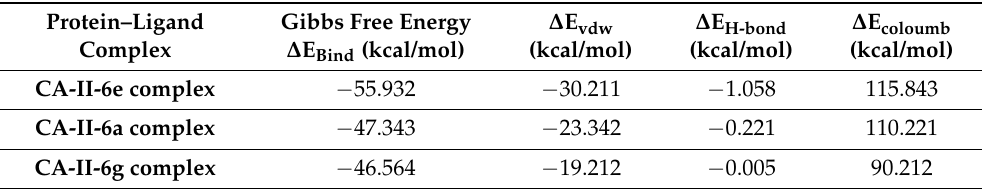
Table 5. Free binding energies calculation using MMGBSA approach.